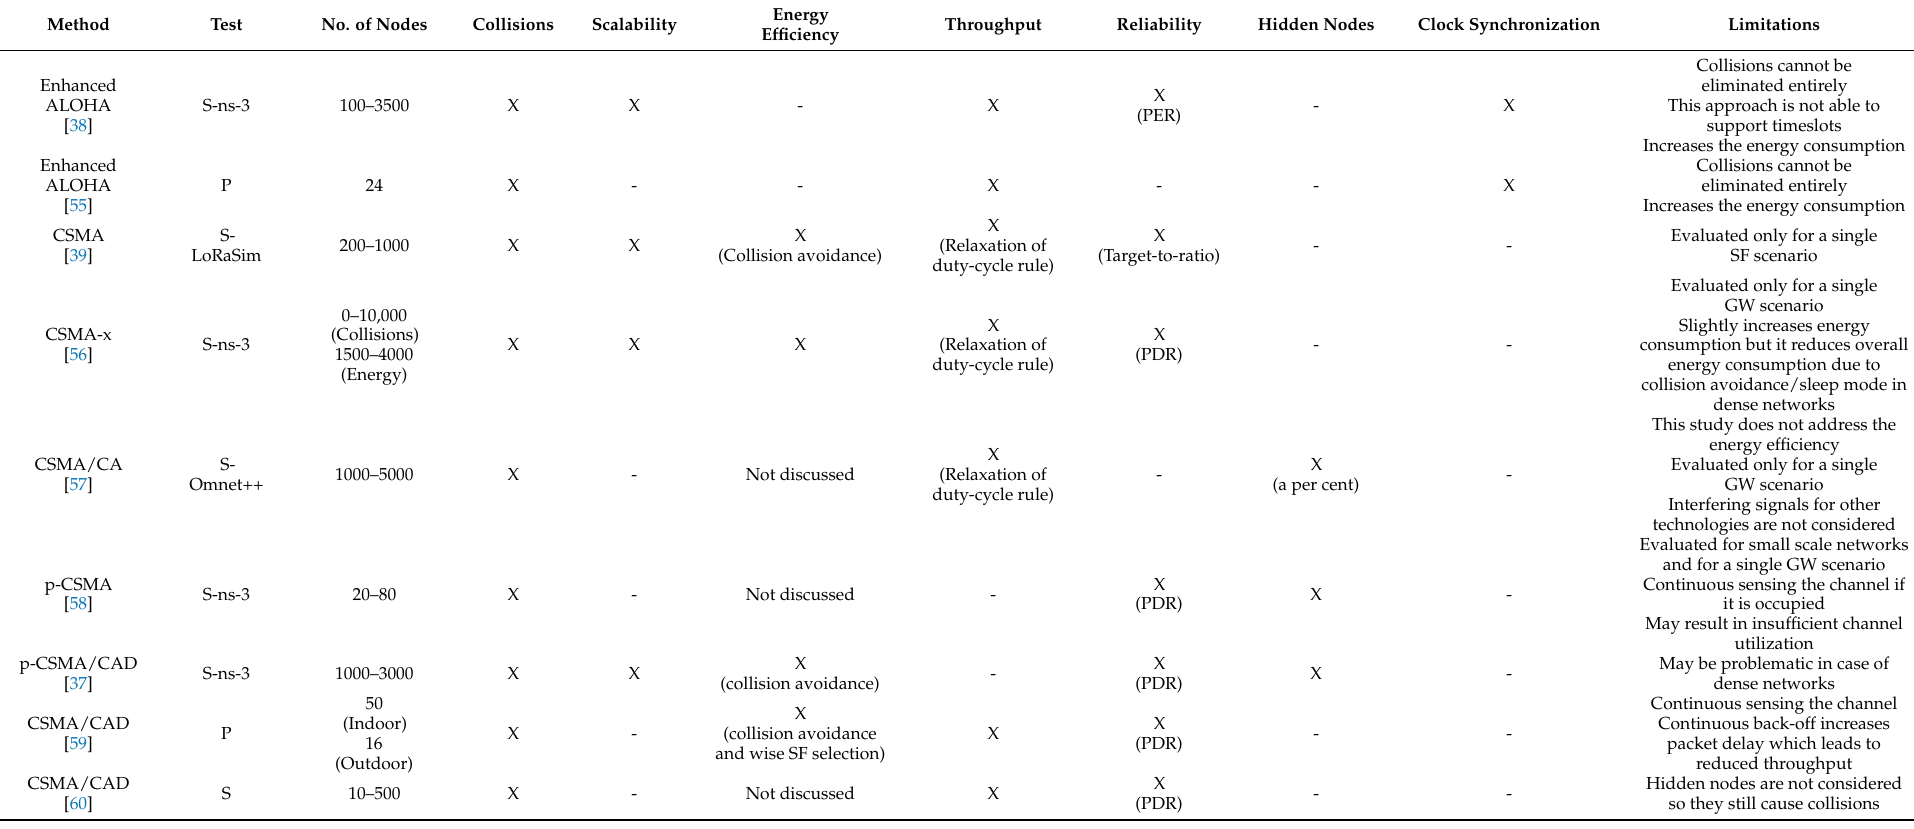
Table 5. Multi-Access Protocols